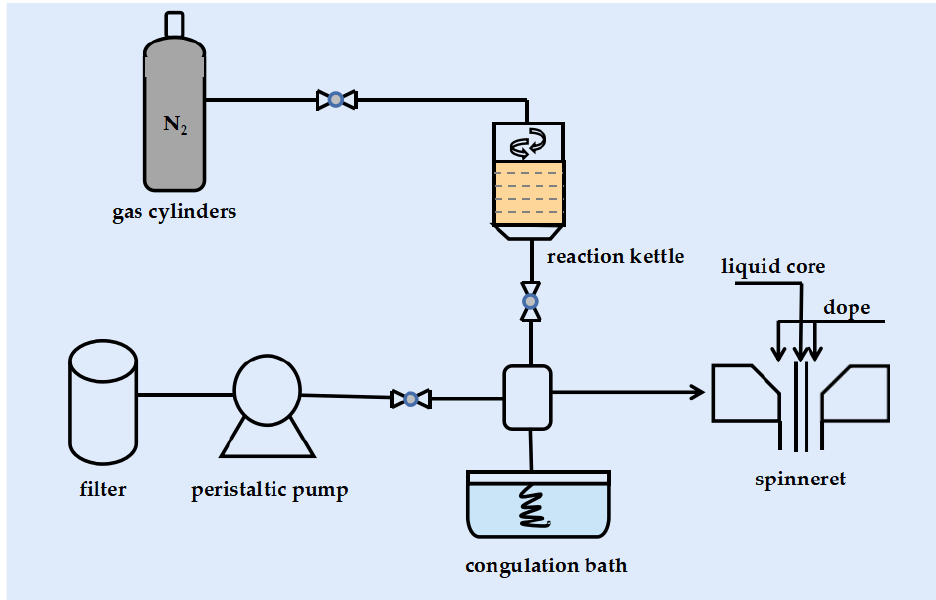
Figure 1. Flow chart of hollow fiber membrane spinning.